Question: Generate an informative caption for the figure above.
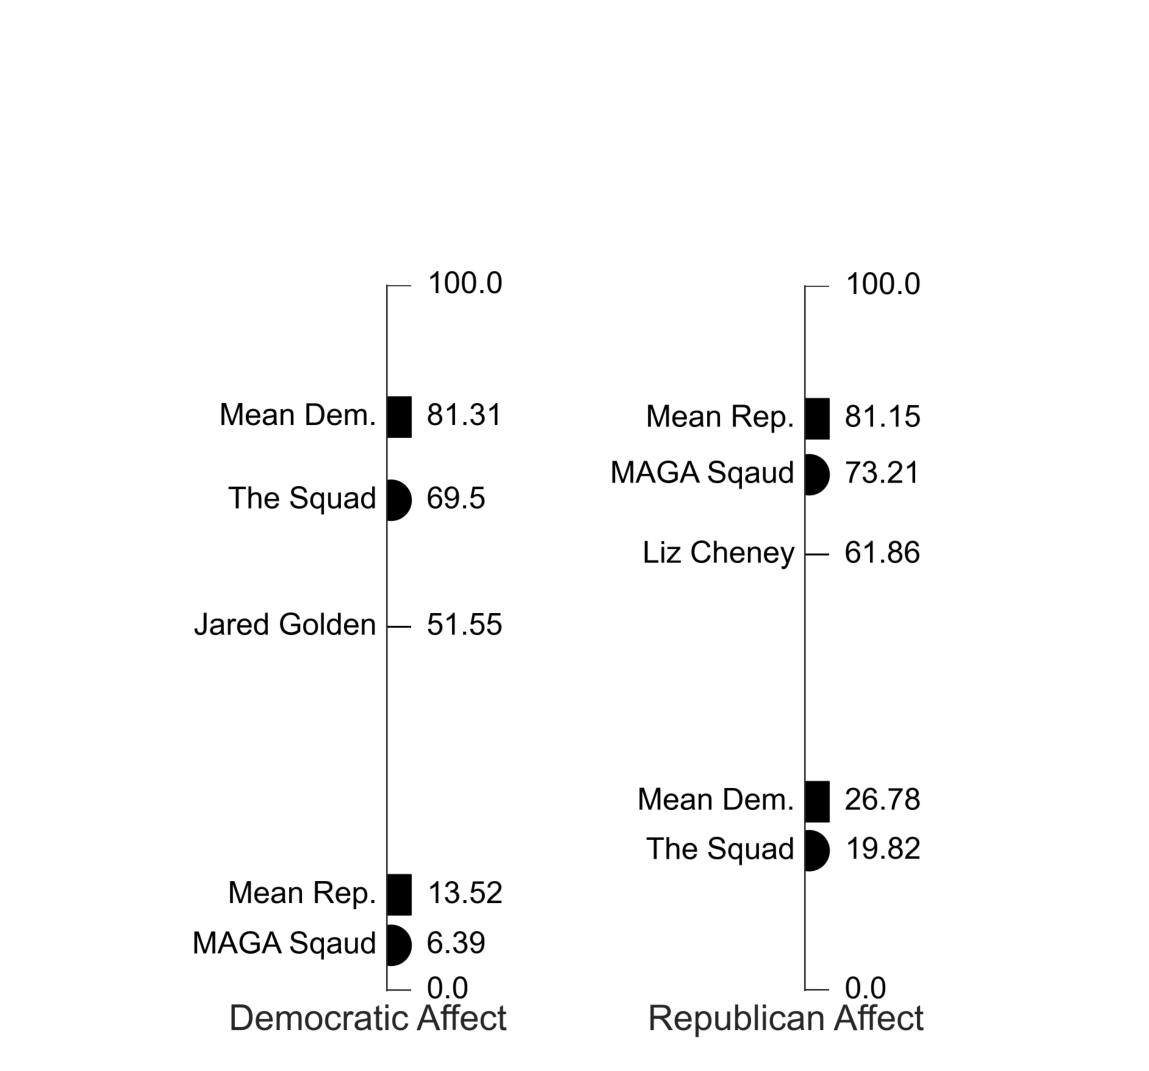
Answer: Party affect similar to feeling thermometers constructed by scaling across items related to the parties and party leadership, then applying a linear transformation on the results so that the lowest observed value is equal to zero and the maximum observed value is equal to 100.